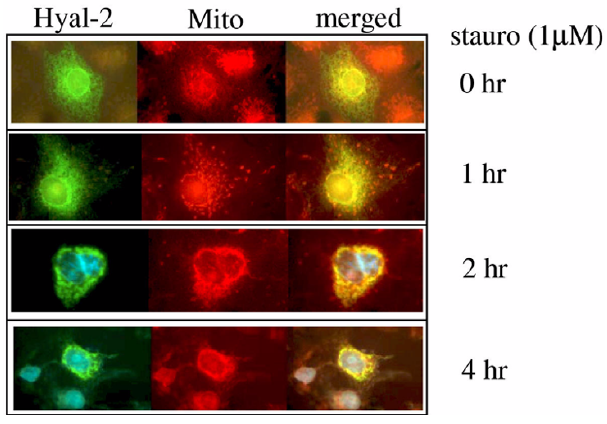
Figure 5 Migration of Hyal-2 to the mitochondria during stau- rosporine-mediated apoptosis. COS7 cells were transfected with the GFP-Hyal-2 construct using FuGene 6 (Roche) or GeneFector (Venn Nova). The cells were cultured for 24–48 hr and then treated with staurosporine (stauro). Mitochon- dria (Mito) were stained with Mitotracker Red and nuclei were stained with DAPI. Co-localization analysis showed that there was a time-related increase in co-localization of GFP- Hyal-2 with mitochondria (see merged), suggesting that a portion of GFP-Hyal-2 migrates to the mitochondria during apoptosis. The nuclear stain is shown at the 2- and 4-hr time points